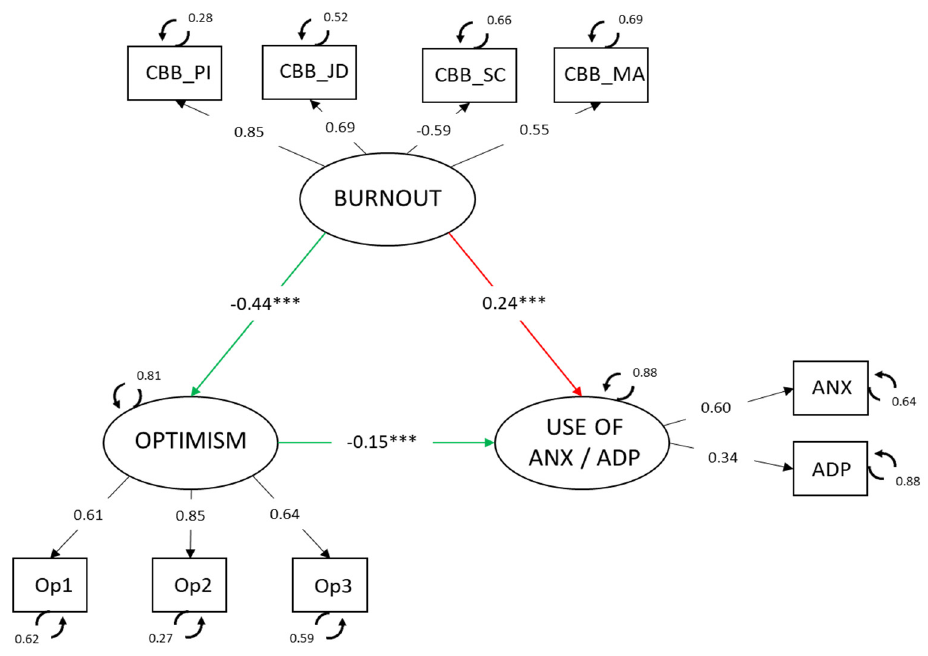
Figure 2. Latent mediation model. Standardized parameters are shown *** p < 0.001. Note: CBB_PI = Personal Impact; CBB_JD = Job Dissatisfaction; CBB_SC = Social Climate; CBB_MA = Motivational Abandonment; ANX = use of anxiolytics; ADP = use of antidepressants.